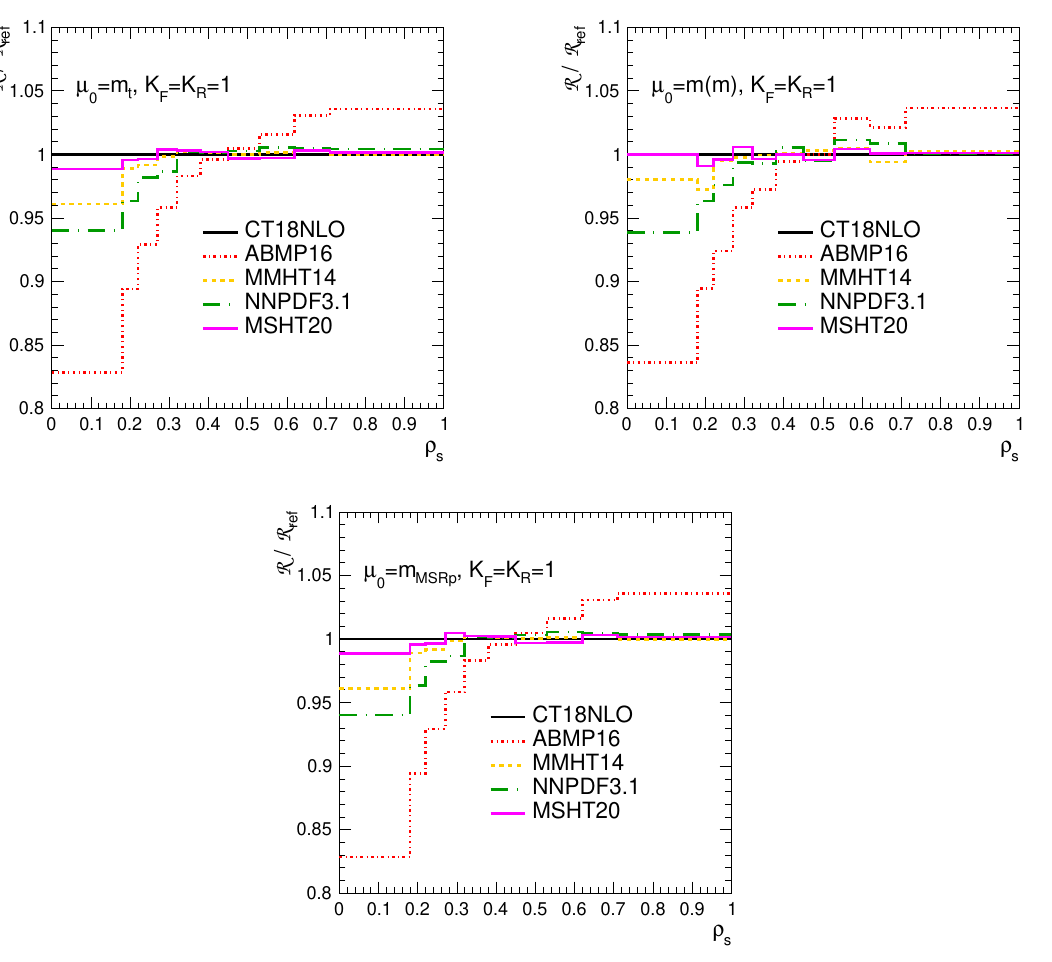
Figure 34 . R distribution using different PDF sets. We chose again µ F = µ R = µ 0 where µ 0 is set equal to the respective mass